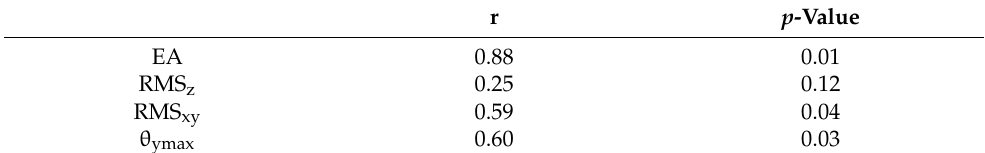
Table 6. Accuracy ( A ), F1-score and goodness index ( G ) achieved by the nine tested